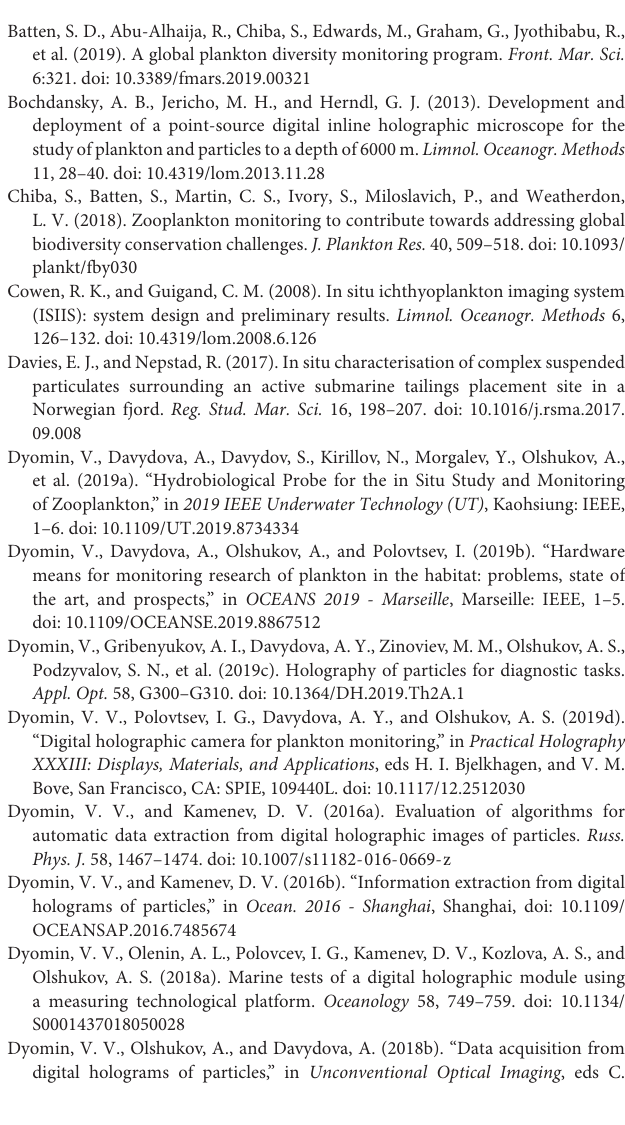
FIGURE S2 | (A) Histogram of particle distribution by taxon (automatic classification). Taxon designation: 1 – phytoplankton colony, 2 – phytoplankton chain, 3 – Copepoda , 4 – Appendicularia , 5 – Rotifera , 6 – Cladocera , 7 – other. (B) Histogram of particle size distribution. FIGURE S3 | 2D display of holographic image obtained using digital holographic camera in the water area of the Kara Sea. The result of automatic classification – the color of the rectangle circumscribed around the particle: black, phytoplankton colony; gray, phytoplankton chain; dark blue, Copepoda ; blue, Cladocera ; red, other. FIGURE S4 | (A) Histogram of particle distribution by taxon (automatic classification). Taxon designation: 1 – phytoplankton colony, 2 – phytoplankton chain, 3 – Copepoda , 4 – Appendicularia , 5 – Rotifera , 6 – Cladocera , 7 – other. (B) Histogram of particle size distribution. TABLE S1 | Confusion